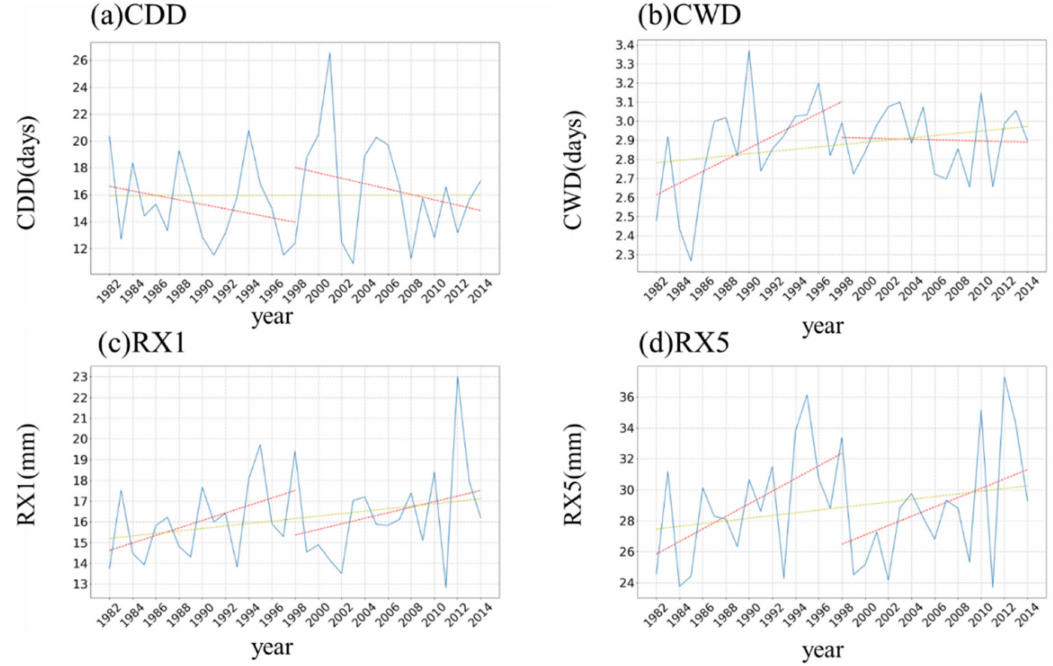
Figure 8. Time series of regional average extreme indexes which related to precipitation: ( a ) con- secutive dry days (days), ( b ) consecutive wet days (days), ( c ) annual maximum 1-day precipitation (mm), and ( d ) annual maximum 5-day precipitation (mm). The red line in the figure represents the trend from 1982–1998 and 1998–2014, the blue line represents the regional average of extreme indexes which related to precipitation from 1982–2014, and the yellow line represents the overall trend from